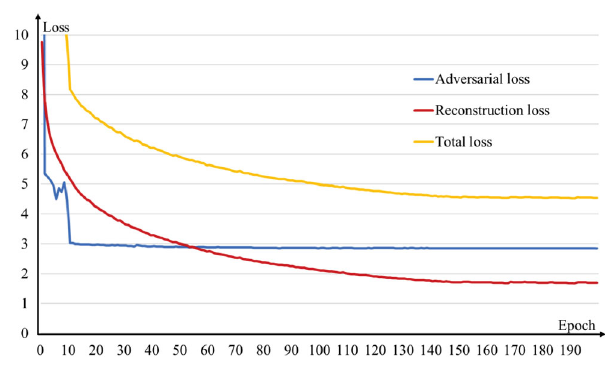
Fig. 4 Training loss for individual loss terms and total